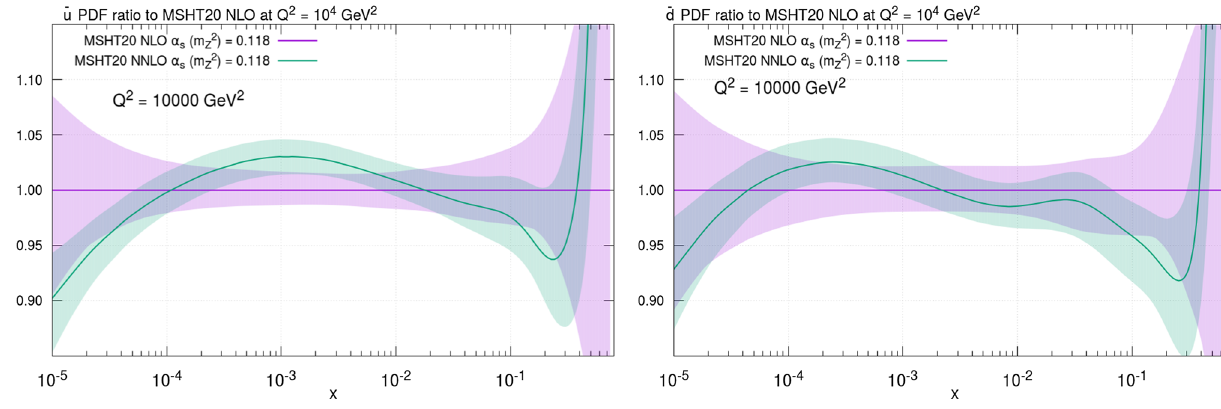
Fig. 38 (Left) ¯ u and (right) ¯ d PDFs showing the ratio of the MSHT20 PDFs to their NLO values, at Q 2 = 10 4 GeV 2